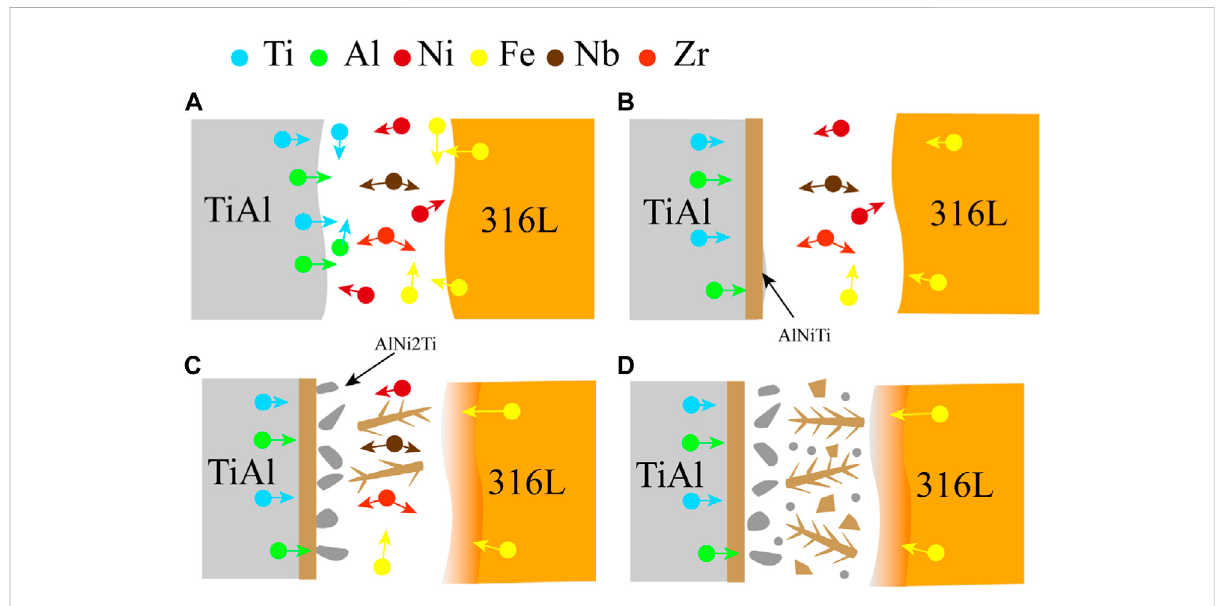
FIGURE 9 Phase formation process of the joint: (A) initial stage of brazing, (B) formation of AlNiTi in the TiAl alloy interface, (C) formation of γ -(Fe, Ni) dendritic phase, (D) solidi fi cation stage of brazing.